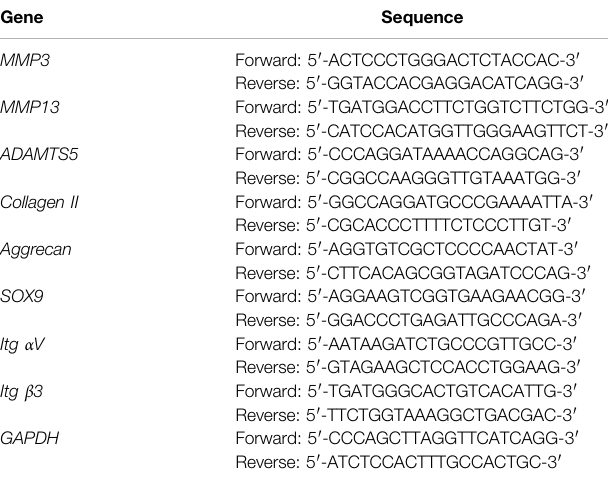
TABLE 1 | Primer sequence used in the RT-qPCR experiment. Gene